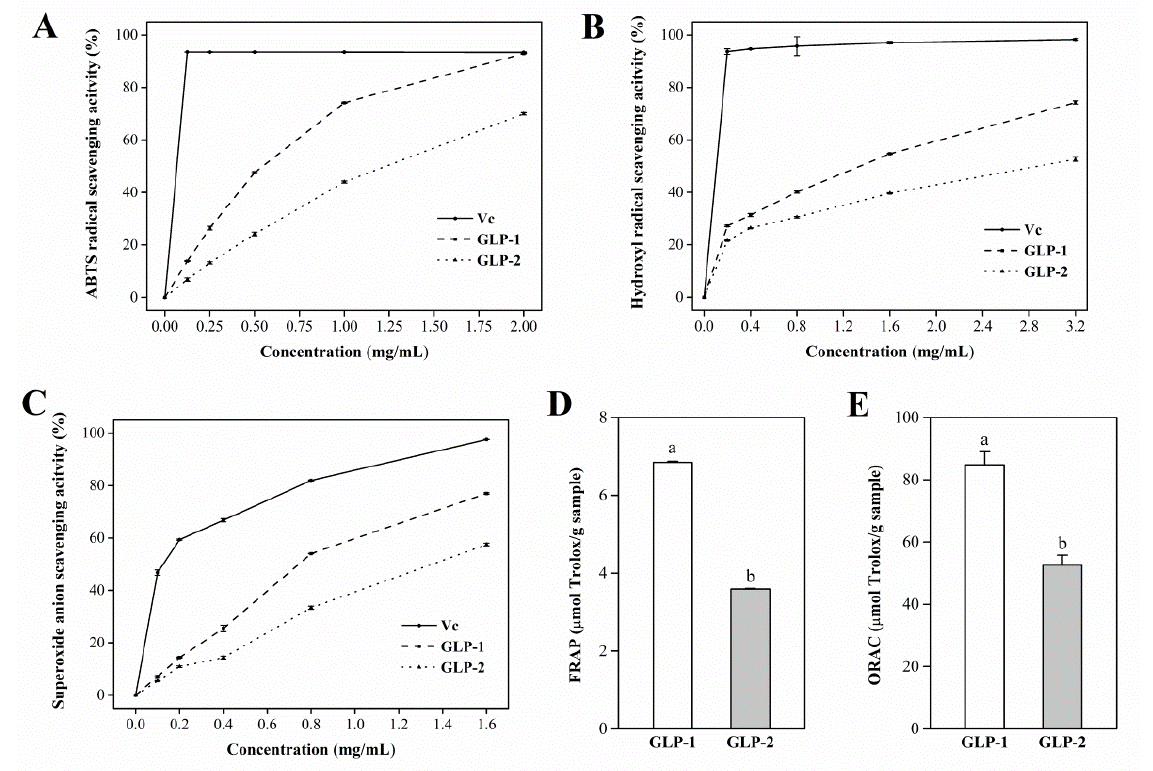
Figure 4. Antioxidant activities of GLP-1 and GLP-2 in five different assays: scavenging capacity of ABTS radical ( A ); scavenging capacity of hydroxyl radical ( B ); scavenging capacity of superoxide anion radical ( C ); TEAC values for FRAP assay ( D ); TEAC values for ORAC assay ( E ). Data are presented as mean ± S.D. Values with different letters (a,b) denote the significant differences ( p <